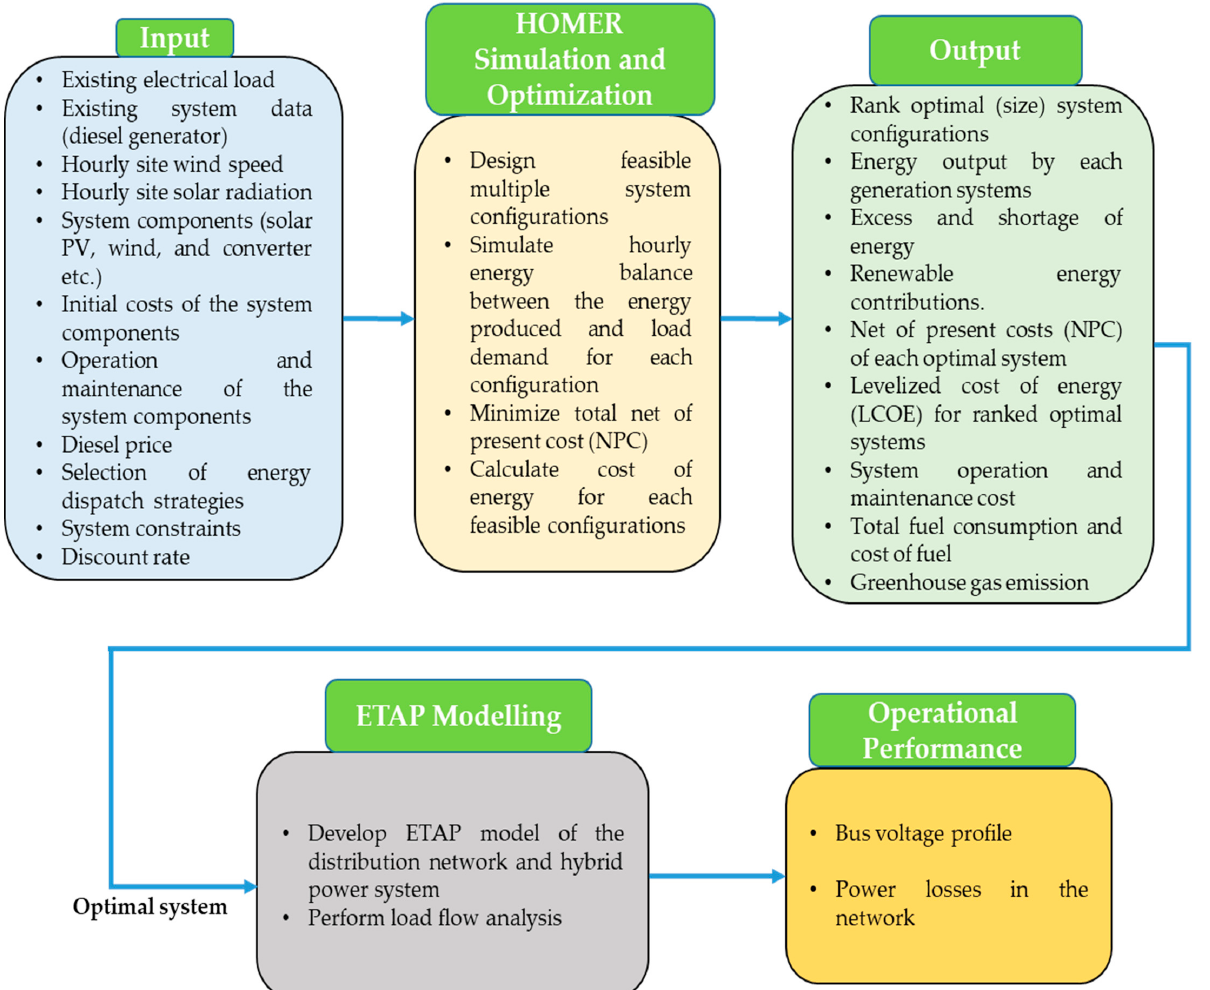
Figure 5. Techno-economic and operational performance analysis process for rural area hybrid mi- crogrid system.